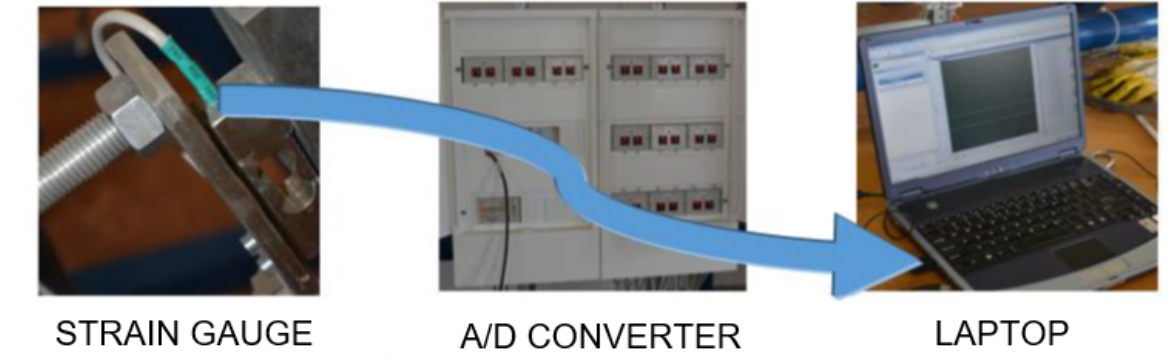
Figure 5: Connection of the measuring chain